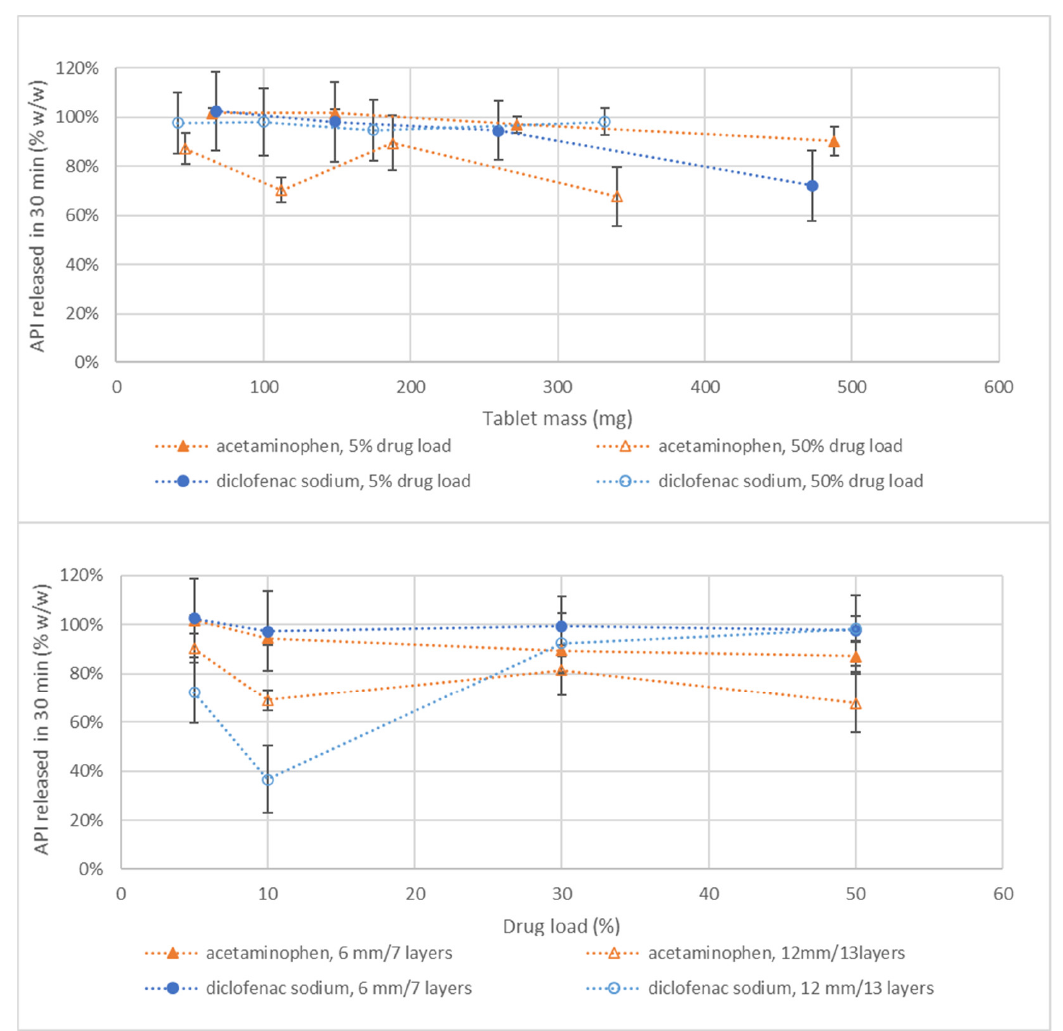
Figure 5. Amount of API released after 30 min versus tablet mass ( upper panel) and drug load ( lower panel) for both the acetaminophen and diclofenac sodium formulations. Tablet mass was increased by printing the blend at a tablet diameter of 6, 9, and 12 mm. The 12 mm tablet was further increased in mass by increasing the number of layers from 7 to 13. Correlation between print settings and tablet mass can be found in Figure 3. The tablets were printed according to the formulations and print settings as provided in Table 4, meaning that the 50% w / w acetaminophen formulation contains 0.5% w / w silica and the 30 and 50% w / w diclofenac sodium formulation contains coarse API and were printed without outer line. The complete dataset of all drug loads can be found in the supplementary information, Figure